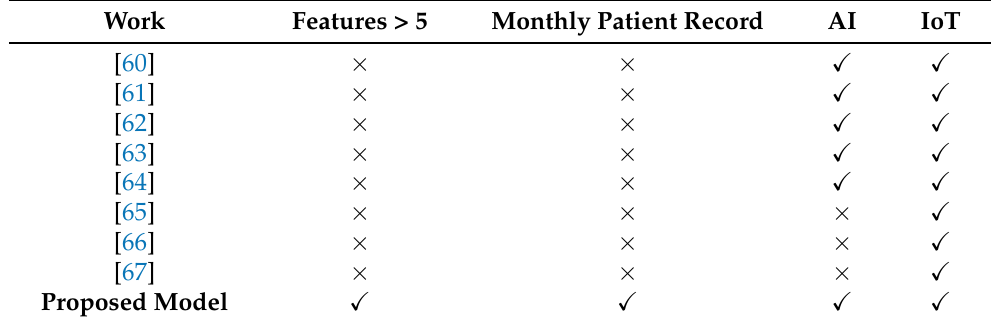
Table 10. Comparison between the related work and the proposed model.